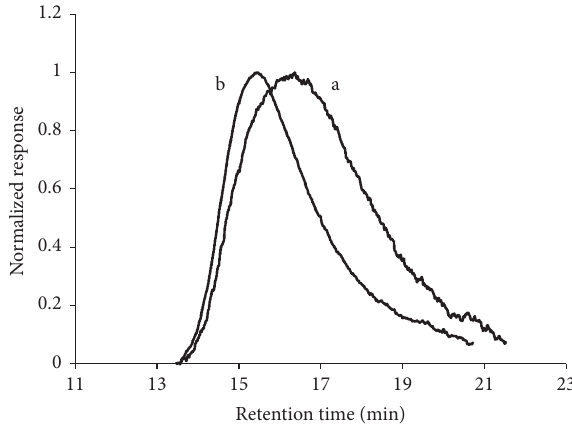
Figure 7: Retention times in GPC analysis of samples of polymeric material taken at (a) 28.7 and (b) 89.7% in the copolymerization of MMA/MAA (2/1,